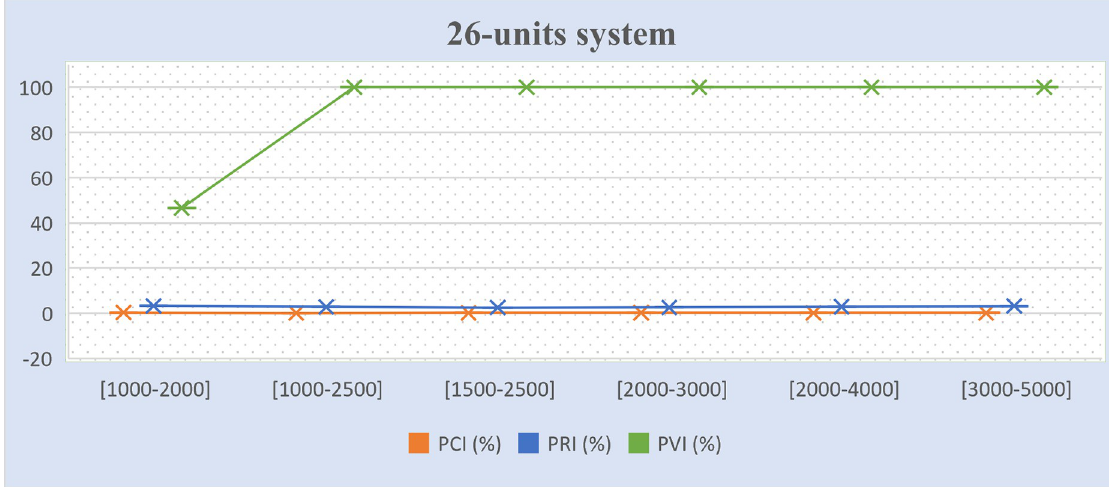
Fig 3. Percentage of improvement in cost, reliability, & violation for GMS model IV with 26-units system.